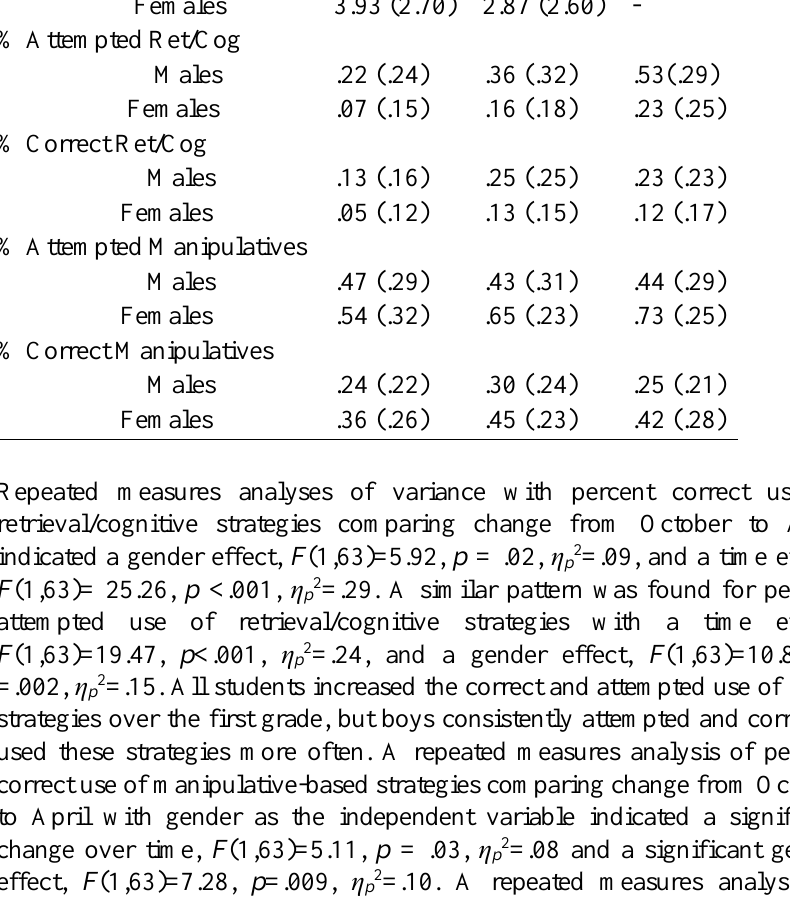
Means and standard deviations for performance goals and strategy use Fall Spring Winter Performance